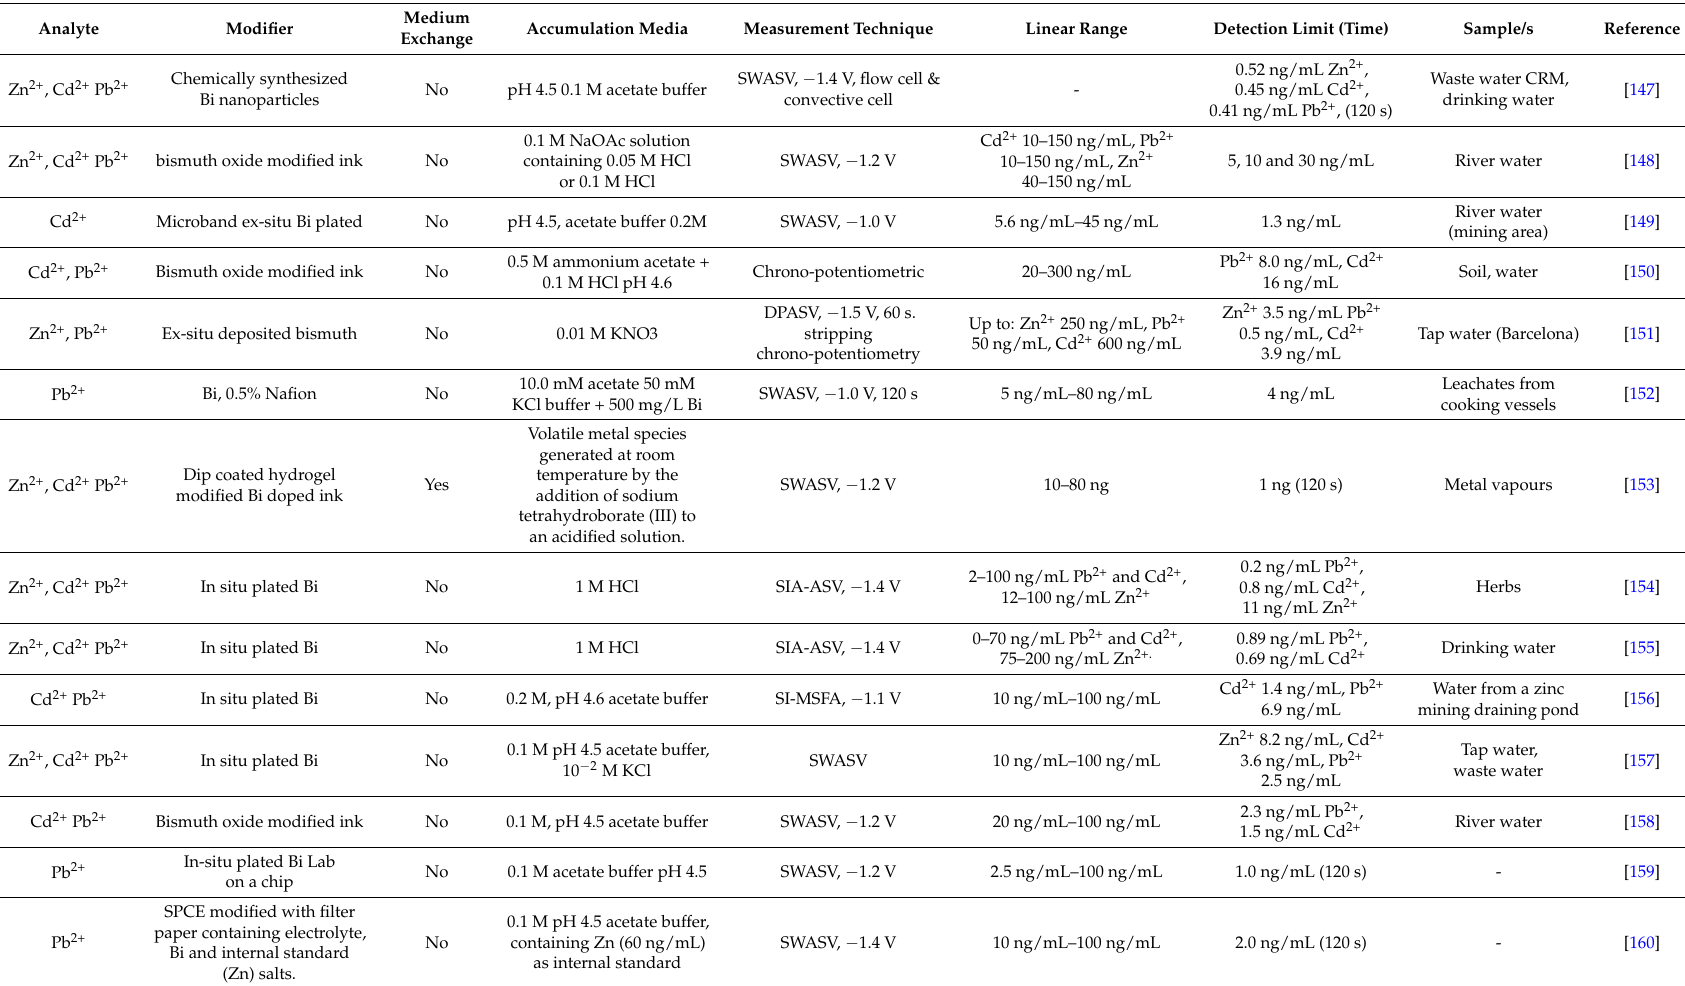
Table 9. Reports of bismuth modified screen-printed carbon electrodes for the determination of metal